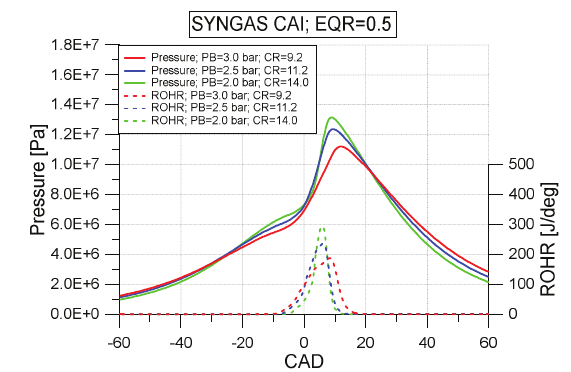
Fig. 13.Visualisation of ignition and combustion for case SCR092ER05P30 (syngas CAI)